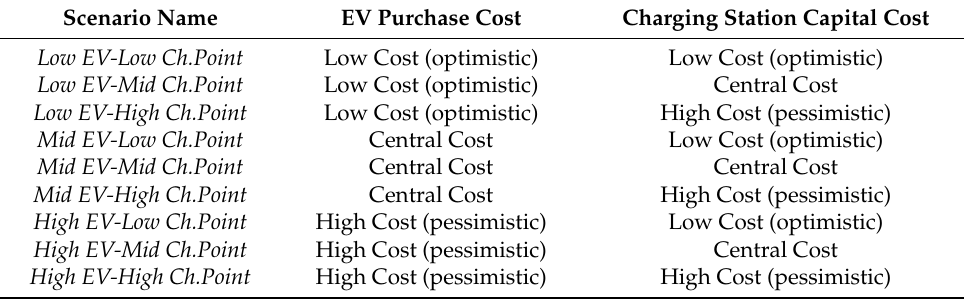
Table 4. Qualitative specifications of the nine scenarios.